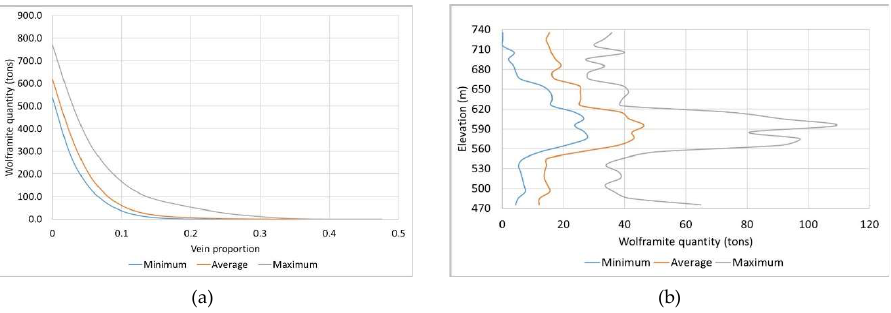
Figure 17. Mineral potential curves: ( a ) Cumulative wolframite quantity (tons) as a function of vein proportion; ( b ) cumulative wolframite quantity (tons) as a function of elevation.